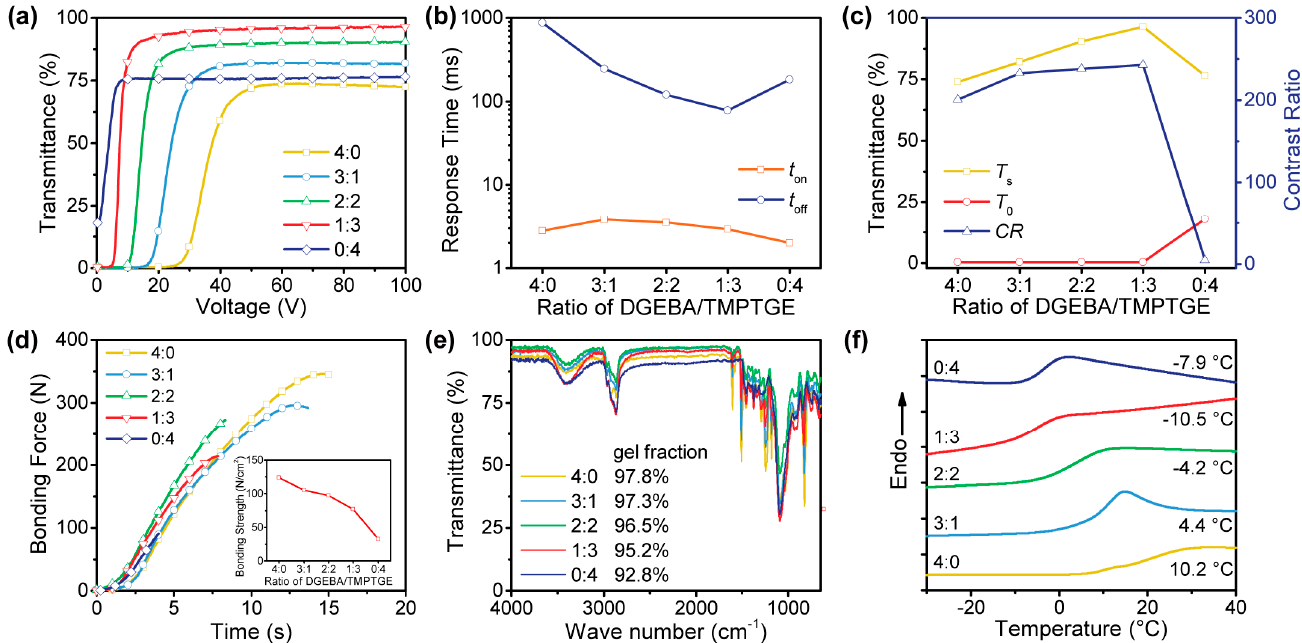
Figure 8. ( a ) The voltage dependence of the transmittance, ( b ) the response time, ( c ) the saturation transmittance, off-state transmittance, contrast ratios, and ( d ) adhesion strength of samples D1–D5; ( e ) FTIR spectra and gel fractions and ( f ) DSC thermographs of the polymer matrix of samples D1–D5.